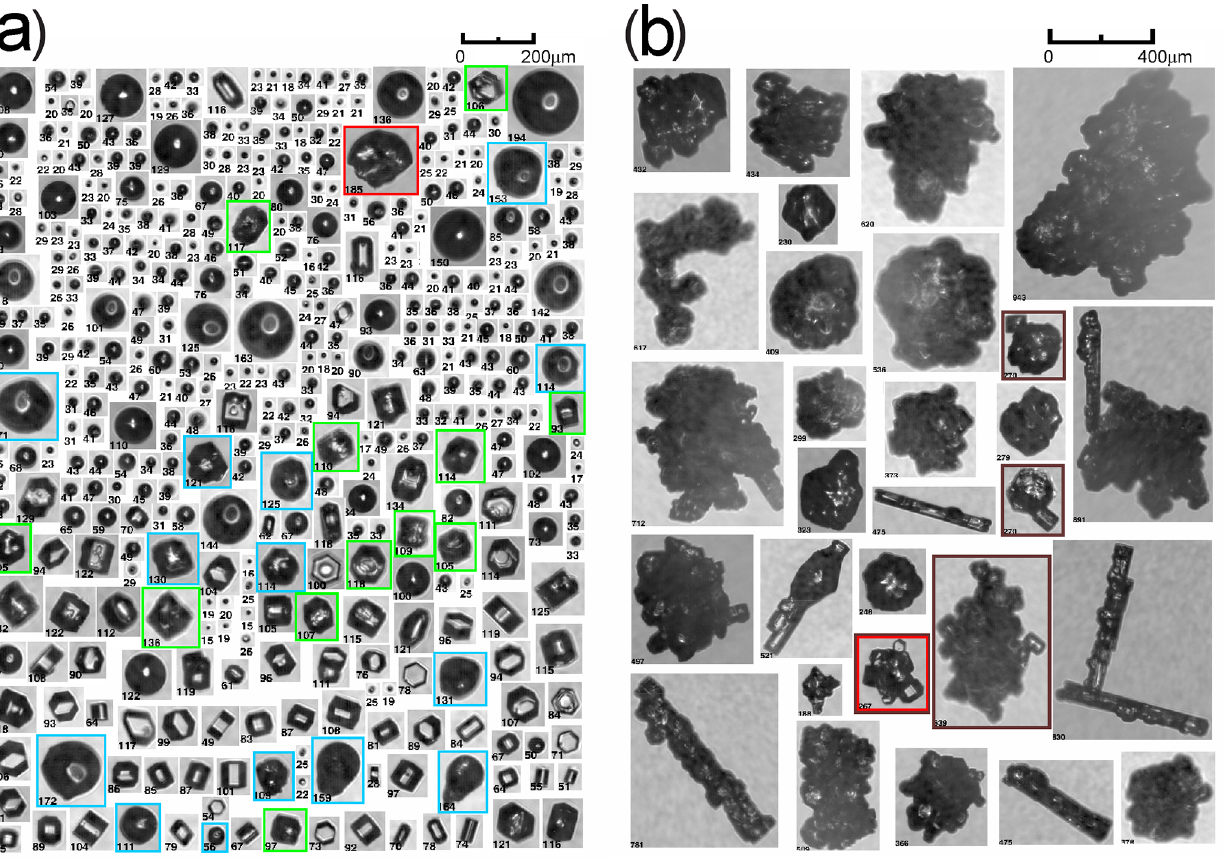
Figure 14. Spatial sequence of CPI images of (a) droplets and faceted ice crystals and (b) background large ice particles. (a) Blue frames indicate frozen droplets with modified shapes, green frames indicate frozen drops with developed facets, and red frames indicate fragments of shattered drops. Numbers under each image indicate their maximum sizes ( L max ). Cloud particles in panels (a, b) are spatially mixed, and they were split between two panels because of their difference in size. The images were sampled at T a = − 2 ◦ C and H = 3500m during 12:29:20–12:30:00UTC on 24 March 2017 during measurements shown in Fig.